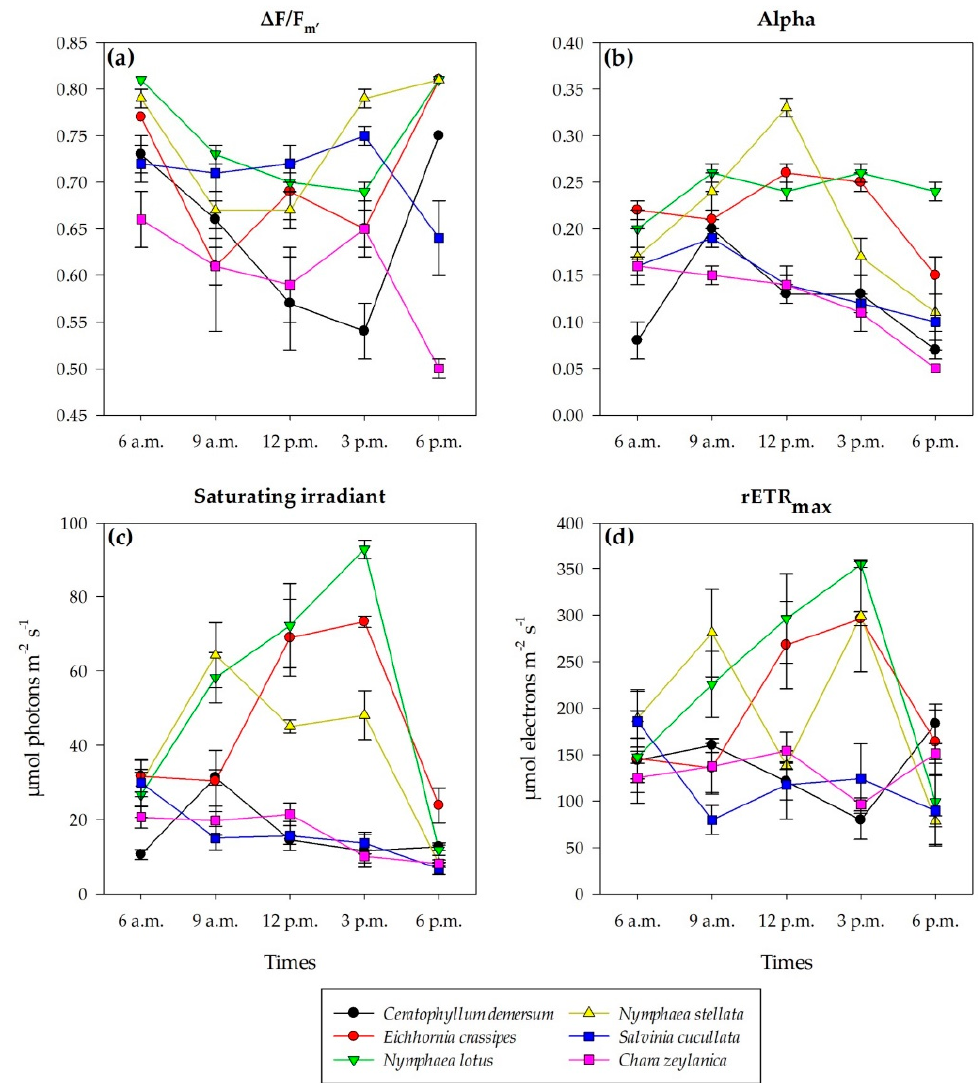
Figure 4. ∆ F/F m’ ( a ), alpha ( b ), I k ( c ), and rETR max ( d ) of six macrophyte species at Thale Noi, Songkhla Lake, from 6 a.m. to 6 p.m. for each species ( n = 4). Data represent mean ± SE.